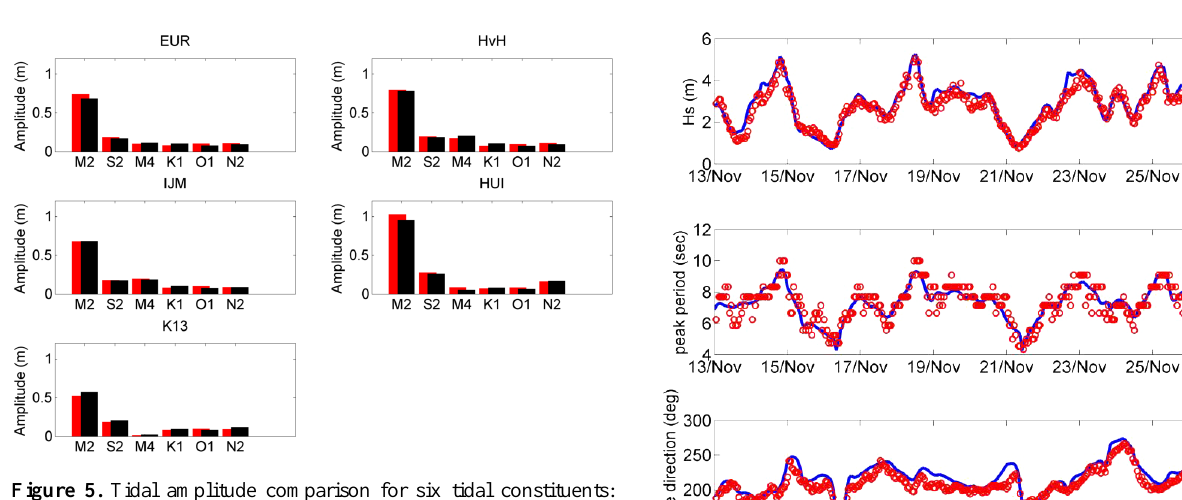
Figure 5. Tidal amplitude comparison for six tidal constituents: black – observation; red – computed.